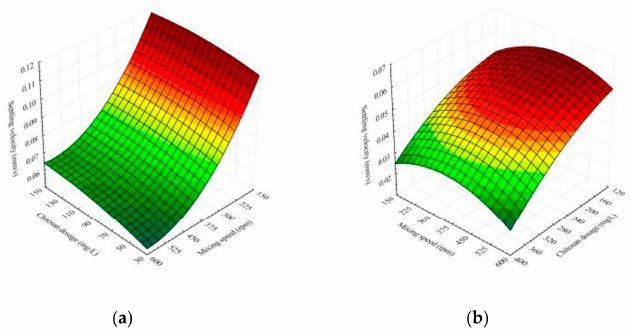
Figure 2. Response surface illustrating the interaction effects of factors on the settling velocity of